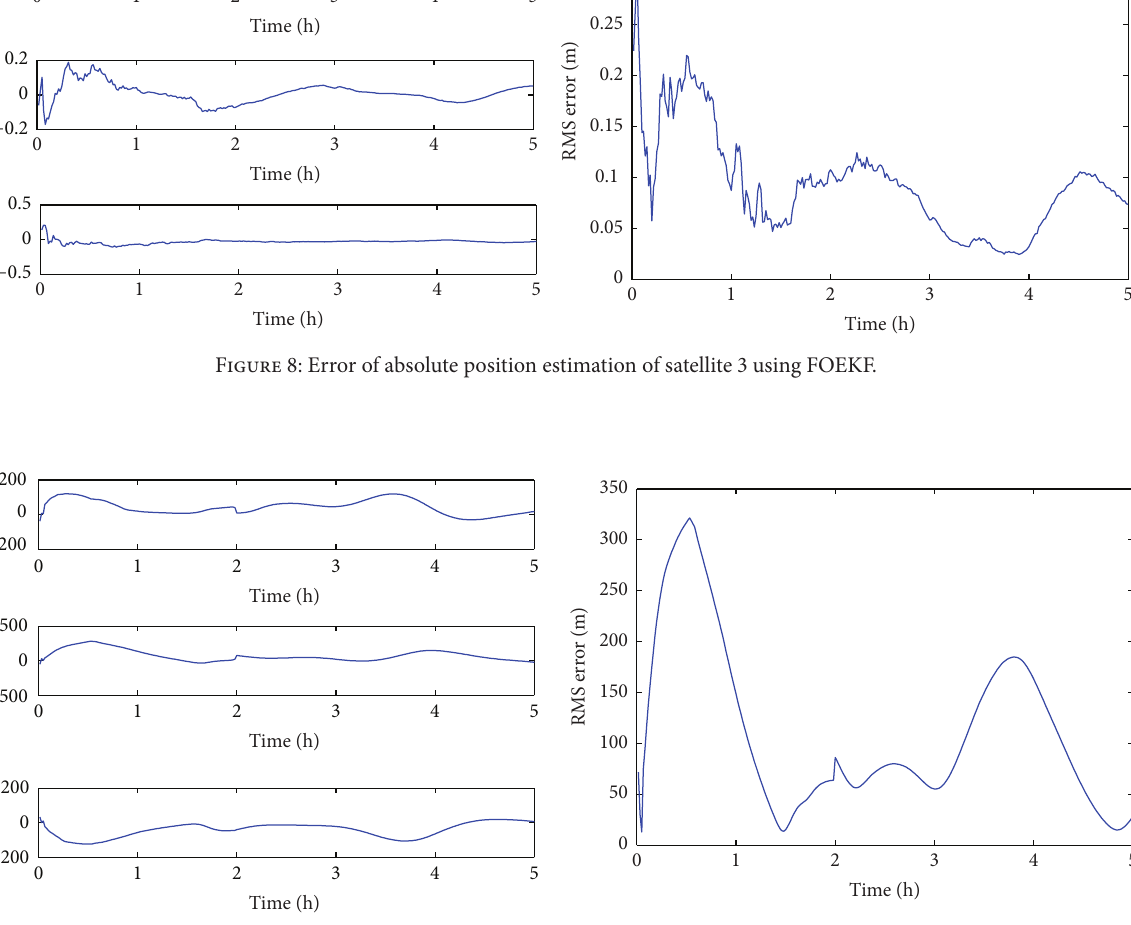
Figure 9: Error of absolute position estimation for satellite 3 using ROEKF.